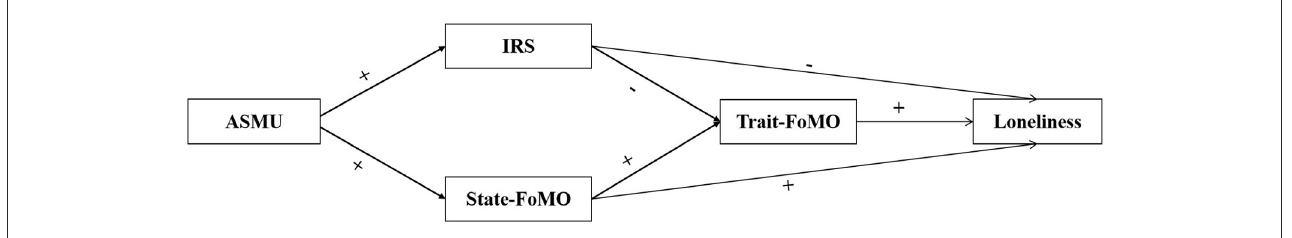
FIGURE1 Proposed research model. Note: ASMU: Active Social Media Use; IRS: Interpersonal Relationship Satisfation; FoMO: Fear of Missing Out.